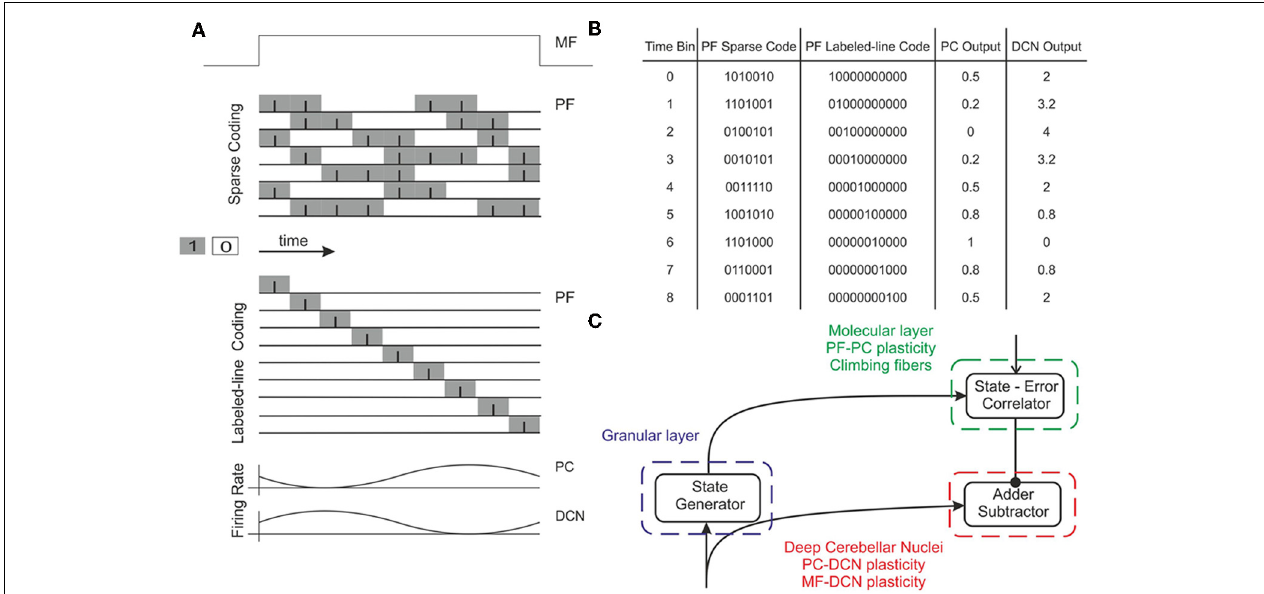
FIGURE 2 | Working hypothesis of cerebellar learning in a manipulation task. In our model, the system is further simplified by computing states without explicit spike representation. (A) During each manipulation trial, the onset of the movement initiates a non-recurrent sequence of firing states in the PFs (Yamazaki and Tanaka, 2007) due to the incoming activity in MFs. Each state is correlated with the error signal, representing the difference between the desired and actual positions of the robotic joint, and reaches the PCs through the CFs. This correlation is thought to occur through plasticity at the PF-PC synapses (Marr, 1969). After repeated pairing of PF states and CF error signals, an association is formed between the two; a learned corrective torque occurs and precedes the wrong movement. This association involves either reduction or increase of PC firing rate at different times. Finally, the temporally correlated signals from PCs are inverted (due to the inhibitory nature of the PC-DCN connection) and rescaled before reaching the motor